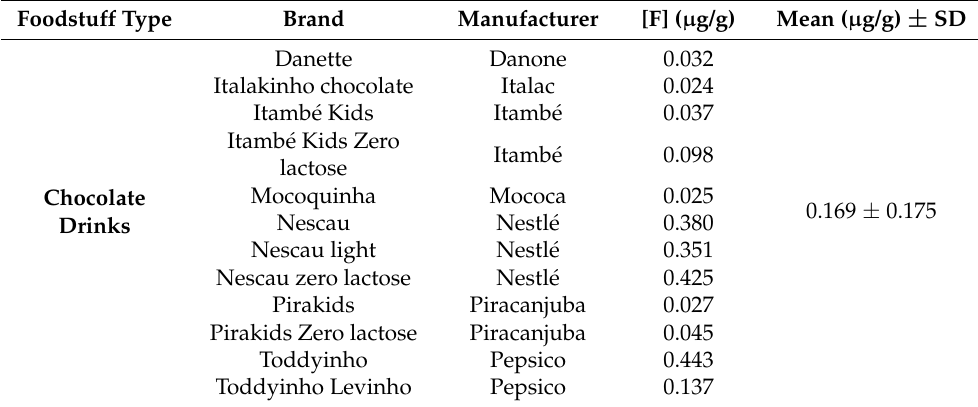
Table 3. Mean of fluoride content of the different types of chocolate drinks that were analyzed.